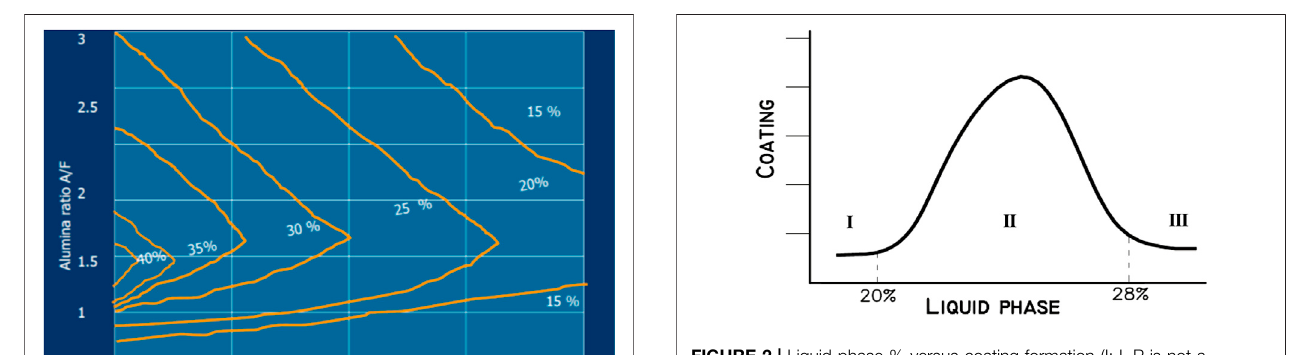
FIGURE 2 | Liquid phase % versus coating formation (I: L.P is not a suf fi ciently pasty form, II: Pasty form of L.P, and III: L.P is very fl uid-liquid) (Sengupta,